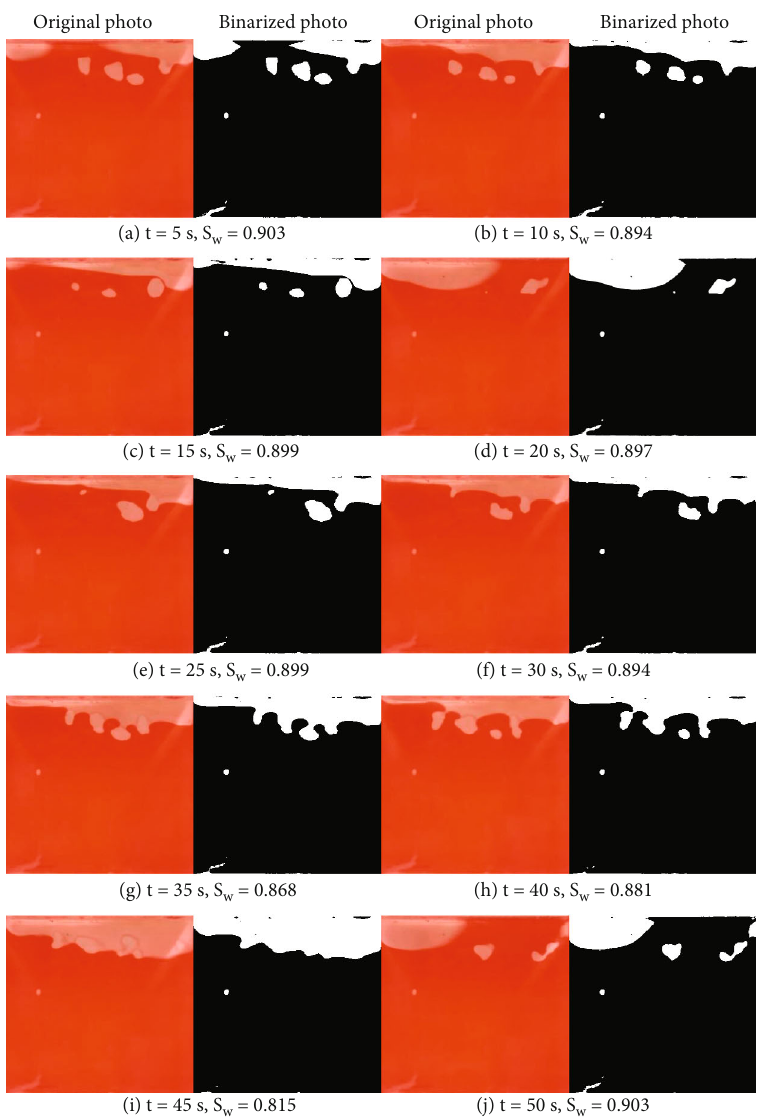
Figure 8: Saturations in fracture 5 at di ff erent moments when W